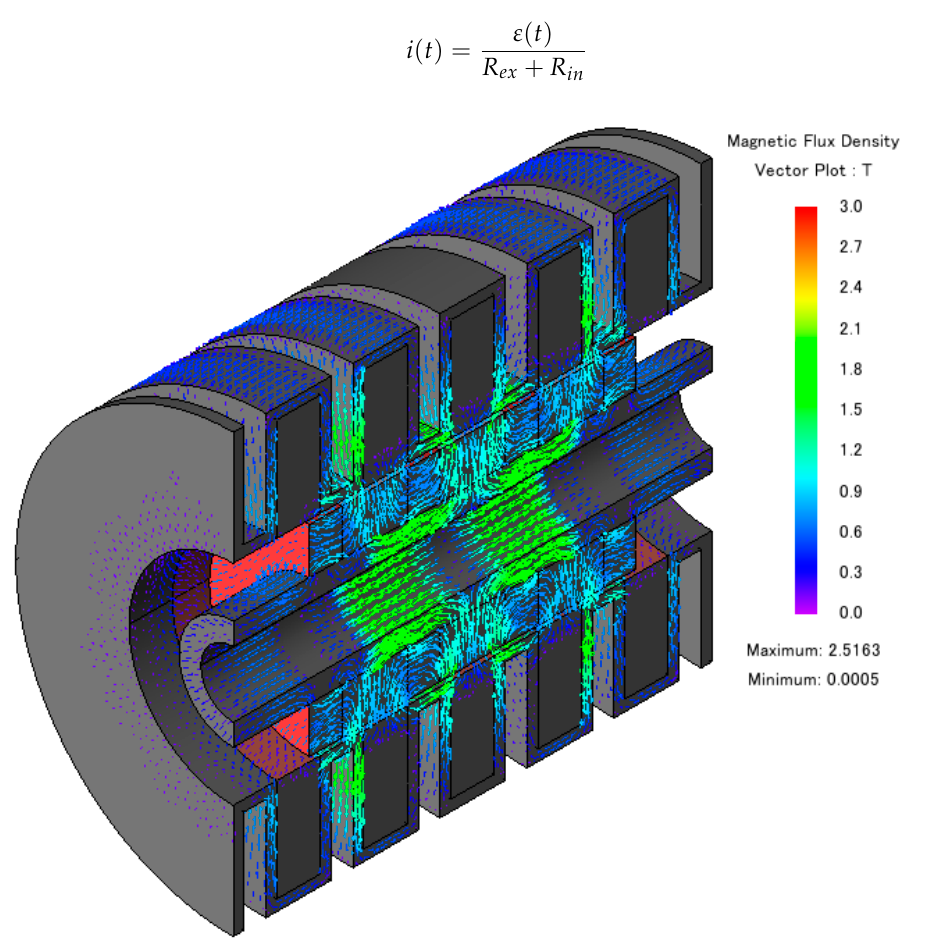
Figure 4. Vector plot of the magnetic flux density across PMLA for the baseline case.